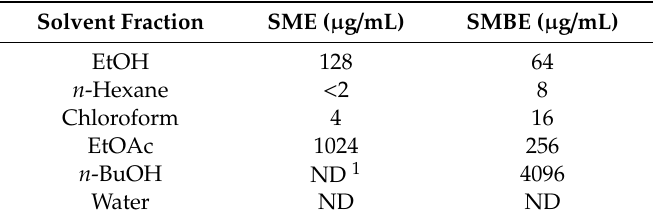
Table 4. MIC value of each solvent of SME and SMBE against B.